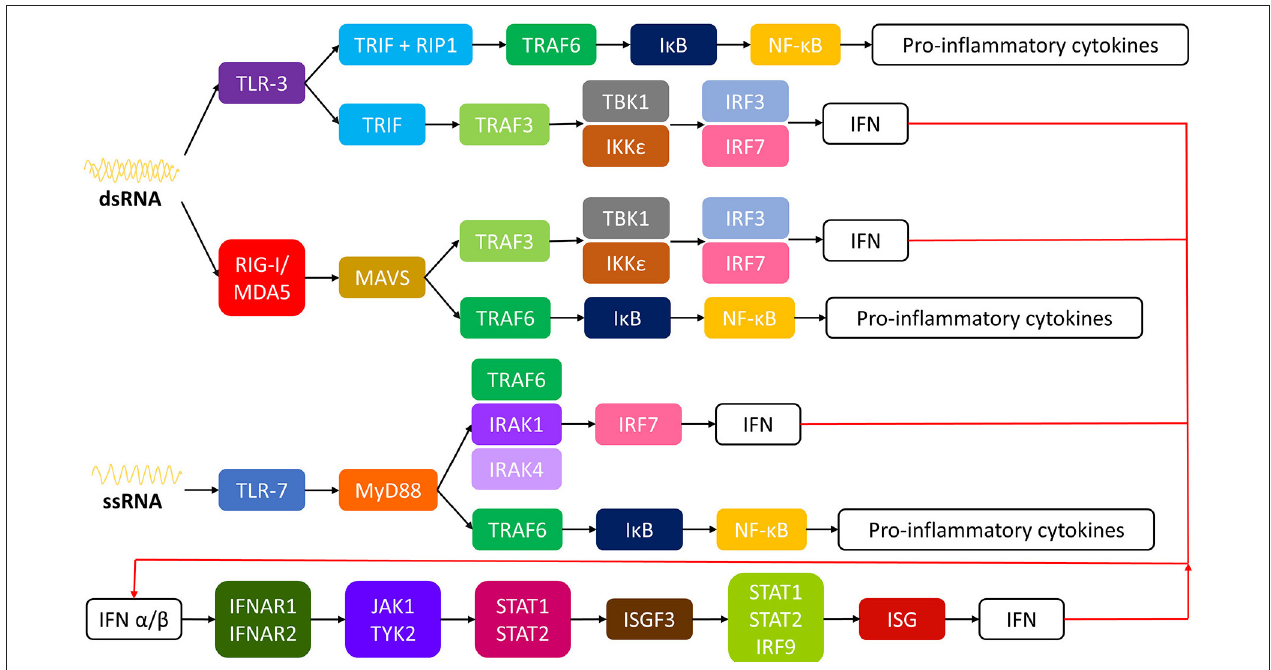
FIGURE 1 | Intracellular pathways of innate immune response to CHIKV. CHIKV, chikungunya virus; ssRNA, single-stranded RNA; dsRNA, double-stranded RNA; TLR, toll like receptor; TRIF, TIR-domain containing adapter-inducing interferon- β ; RIP-1, receptor interacting protein 1; TRAF, TNF receptor associated factor; I κ B, inhibitor of κ B; NF- κ B, nuclear factor kappa-light-chain-enhancer of activated B cells; TBK1, tank binding kinase; IRF, interferon regulator factor; IFN, interferon; IKK ε , inducible I κ B kinase; RIG-I, retinoic acid-inducible gene I; MDAS, melanoma differentiation-associated protein 5; MAVS, mitochondrial antivirial signaling; MyD88, myeloid differentiation primary response gene 88; IRAK, interleukin-1 receptor-associated kinase; IFNAR, interferon α / β receptor; JAK1, Janus kinase 1; TYR2, tyrosine kinase 2; STAT, signal transducer and activator of transcription; ISGF3, ISG factor 3; ISG, interferon stimulated